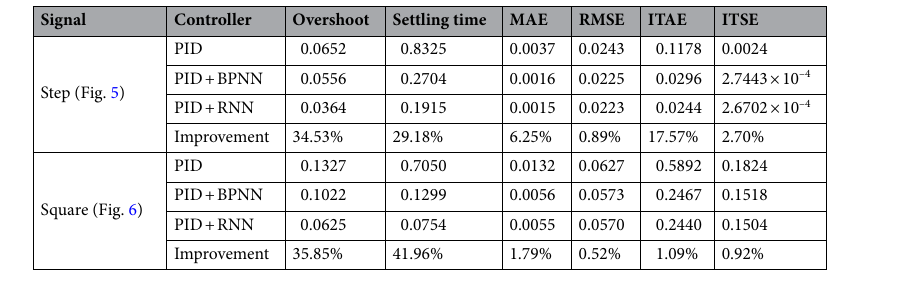
Table 3. Comparisons of simulation results of tracking step and square